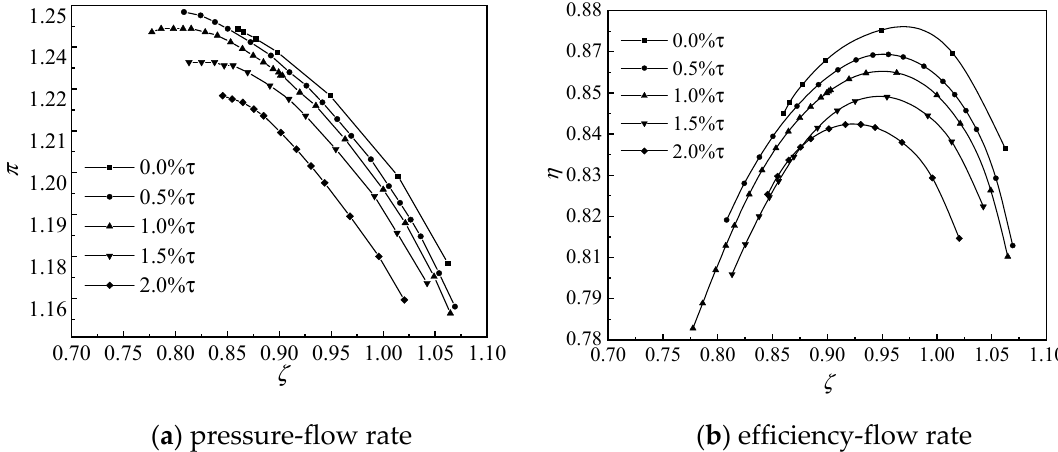
Figure5. Performancecurvesofdifferenttipclearancemodels. ( a )pressure-flowrate;( b )efficiency-flowrate.